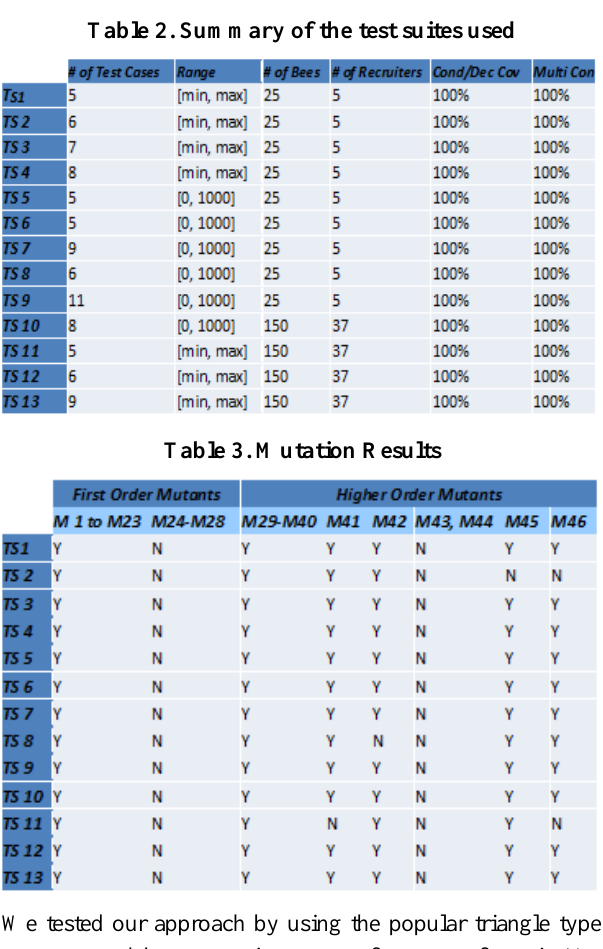
Figure 5. CFG for the triangle program